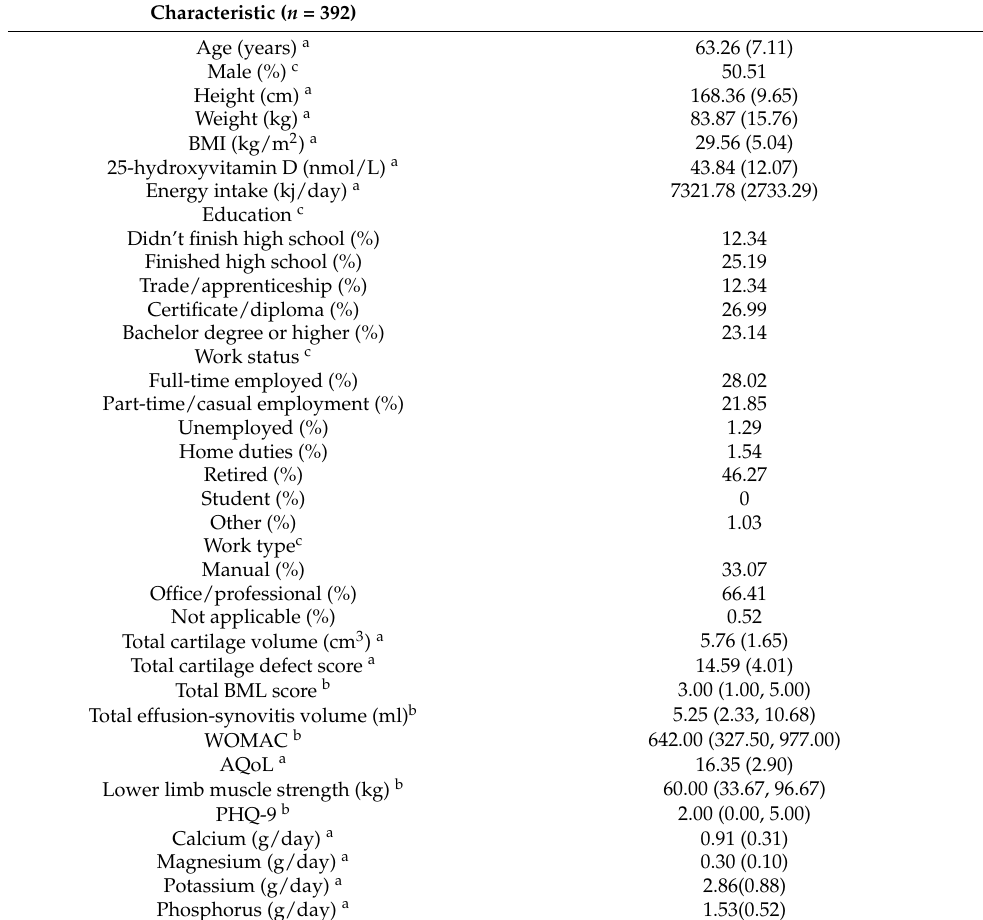
Table 1. Characteristics of participants at baseline.